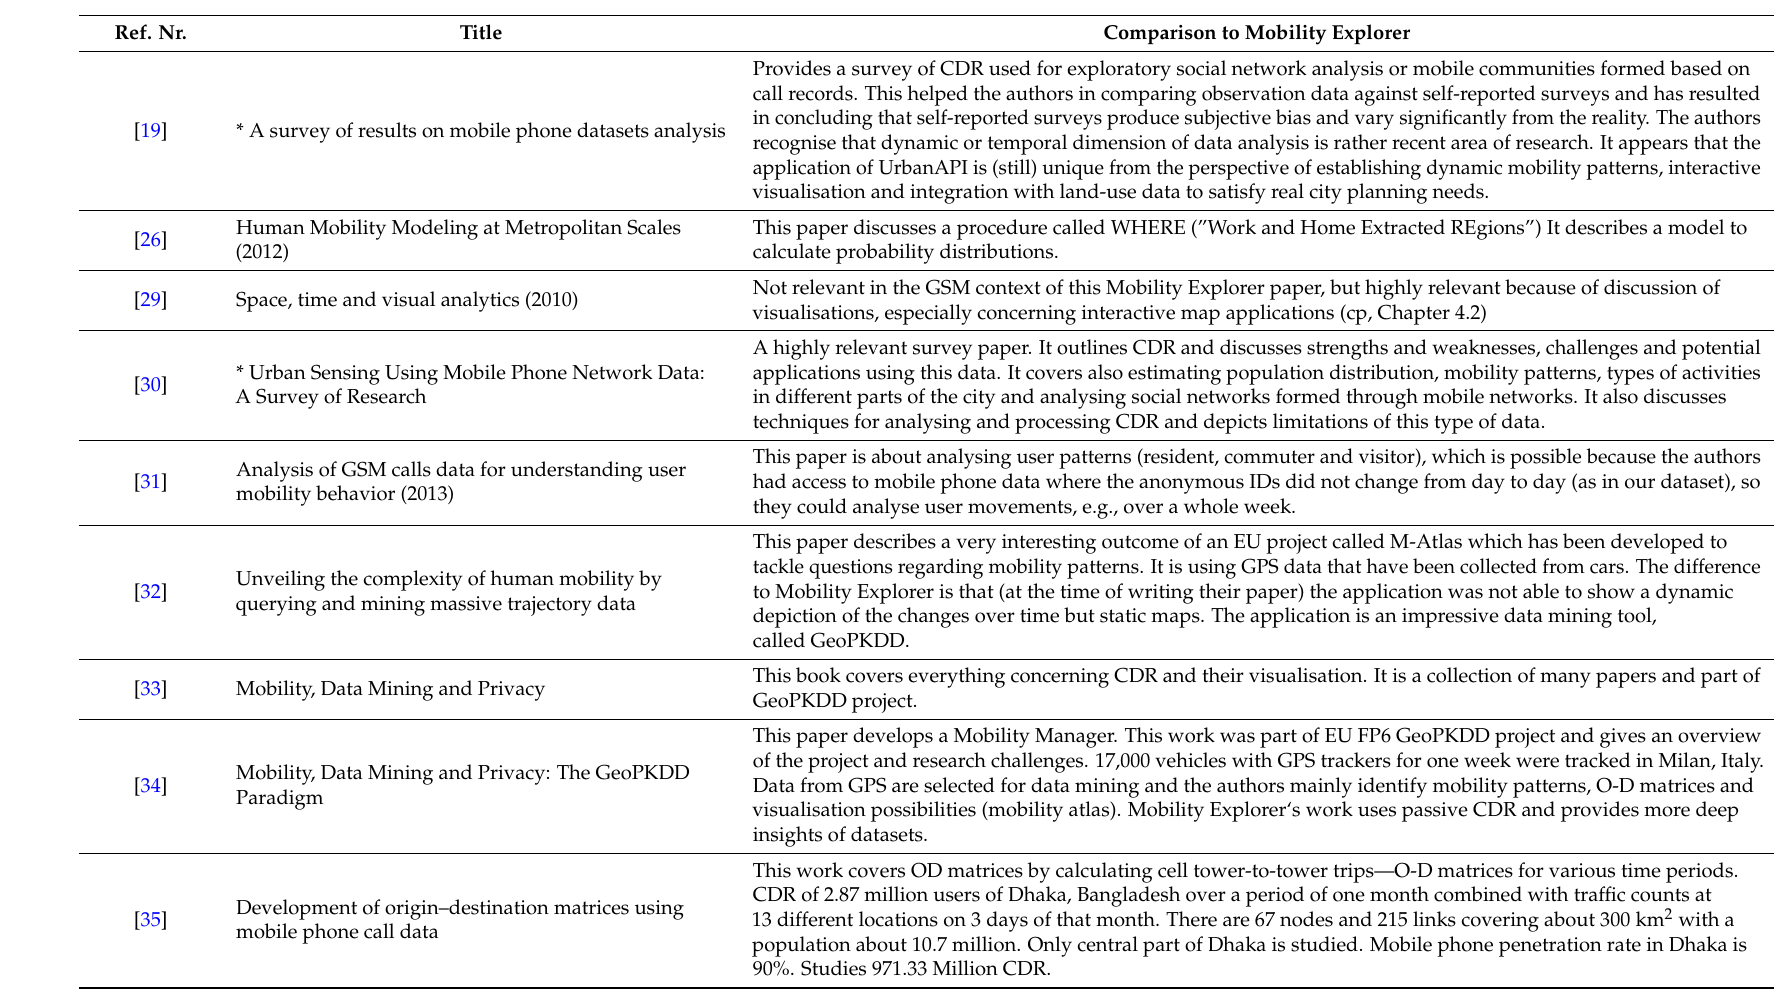
Table A2. Summary of related work in comparison to Mobility Explorer (cp. also Table A1 above). Ref.